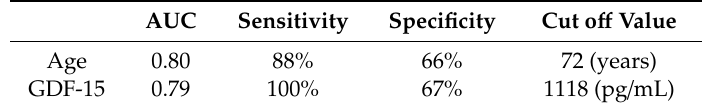
Figure 1. Comparison of GDF-15 in coexistence status with sedentary lifestyle and cognitive risk in all subjects. Data are presented as box plot including median (IQR). P -values compared among subjects by Kruskal–Wallis test. GDF-15: Growth Differentiation Factor-15, Sedentary lifestyle + : EX (MET × hours per day) < 1.5, Sedentary lifestyle − : EX (MET × hours per day) ≥ 1.5, Cognitive risk + : MoCA-J scores ≤ 25, Cognitive risk − : MoCA-J scores > 25.